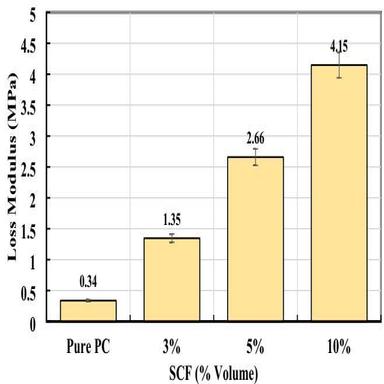
Variation in loss modulus of PC composite with varying percentage of SCF.